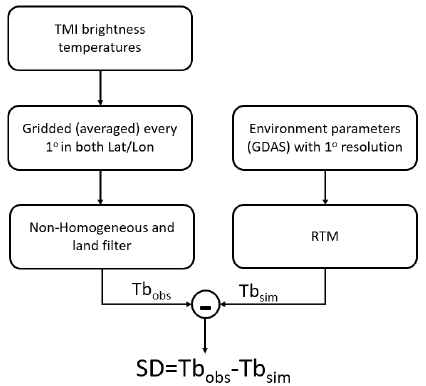
Figure 8. Flow chart for Single Differences procedure, between observed and modeled brightness Figure temperature.